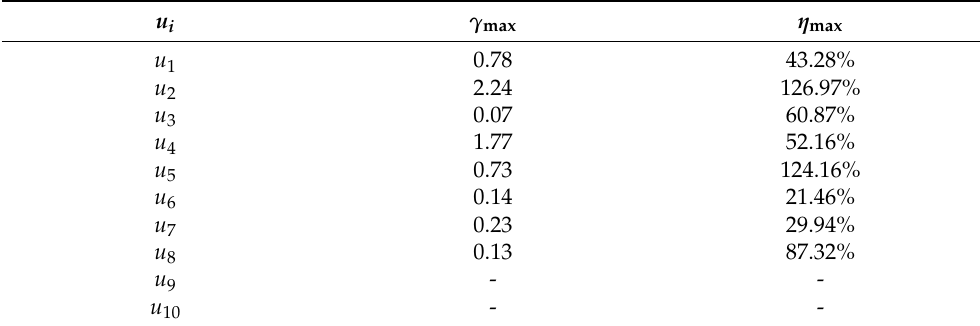
Table 11. Deviation degree of fault influence (Keep two decimal places for